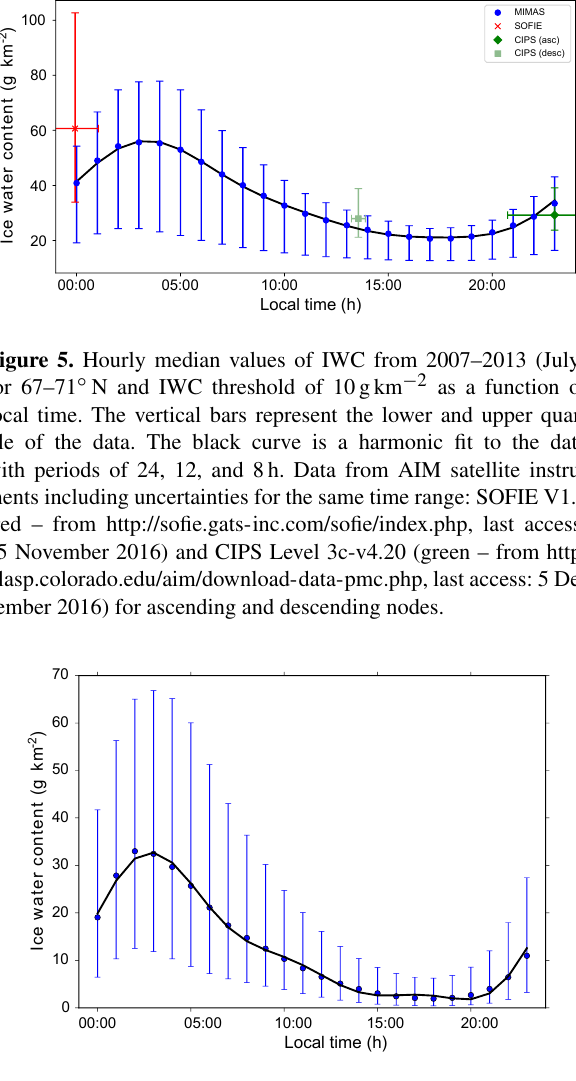
Figure 6. Hourly median values of IWC from 2007–2013 (July) for 67–71 ◦ N as a function of solar local time. No threshold has been applied, IWC values of zero (no PMCs) are included. The vertical bars represent the lower and upper quartile of the data. The black curve is a harmonic fit to the data with periods of 24, 12, and